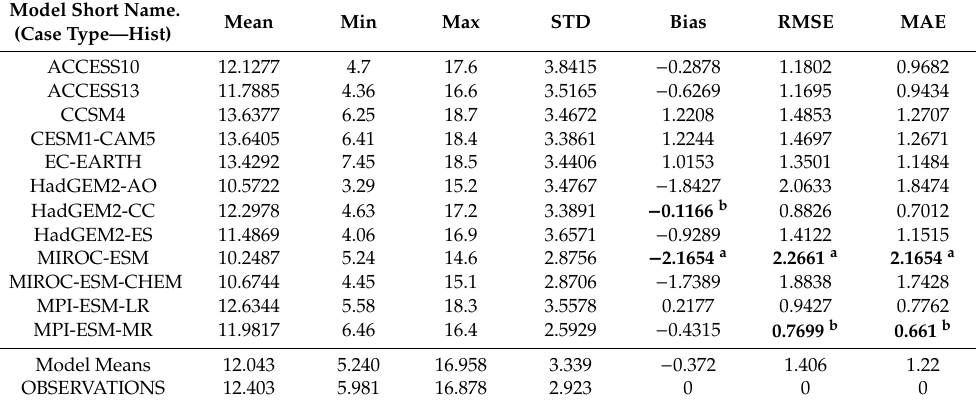
Table 2. Statistics of SIE time series of historical simulations for 1979–2005. The basic statistics of the model means and observed SIE time series are also included in the last two rows for